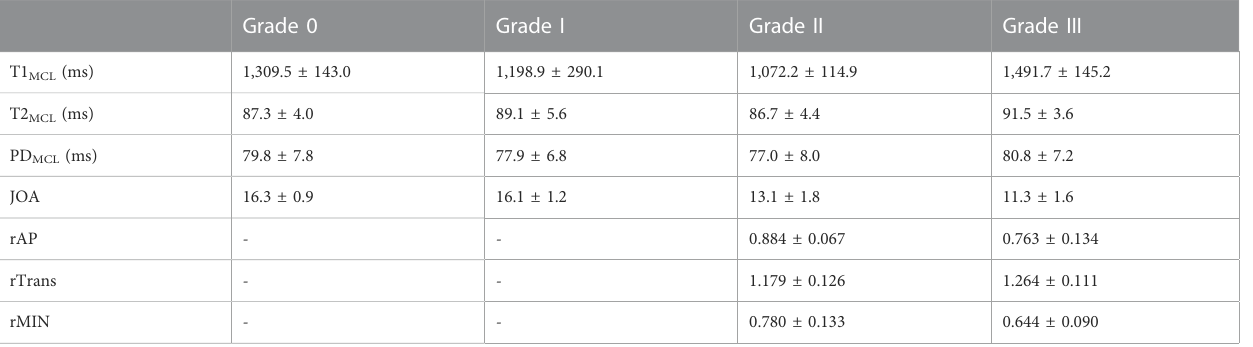
TABLE 2 The mean and standard deviation of MAGiCquantitative values (T1,T2 and PD), clinical score, anddiameters values of the spinal cord at MCL in different grades of CSM